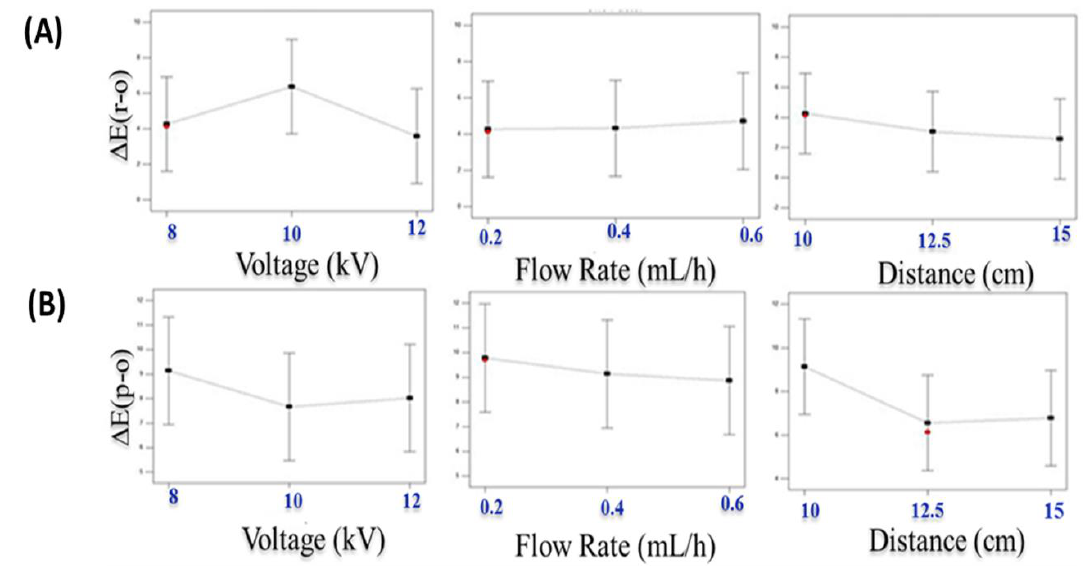
Figure 3. Effects of electrospinning process variables on total color difference ( ∆ E ) values of the electrospun tags. (( A ): ∆ E (r-o) ; ( B ): ∆ E (p-o) ; subscripts: o-original; p-photo-activated; r-recovered).